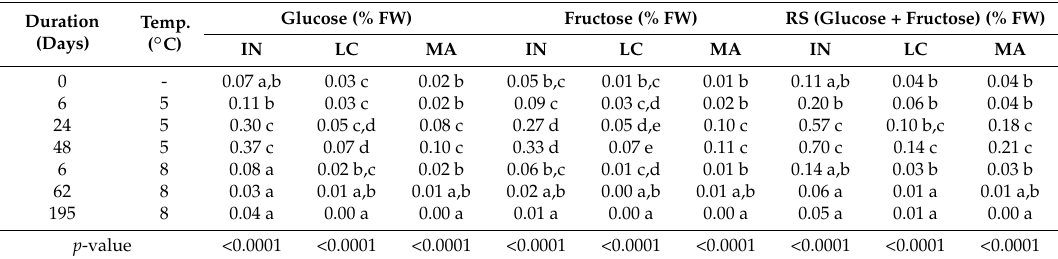
Table 2. Sugar values of individual potatoes. Sugar values were statistically analyzed by the non-parametric test of Kruskal–Wallis ( p = 0.05); mean values comparisons have been processed by the Dun test. RS: Reducing sugars, FW: fresh weight.